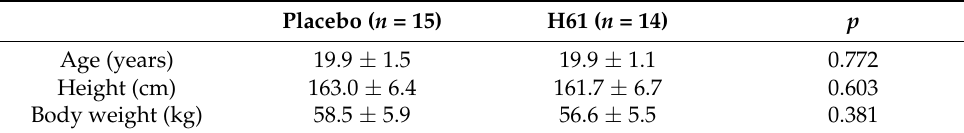
Figure 1. Flow diagram of the participants. Table 1. Characteristics of the